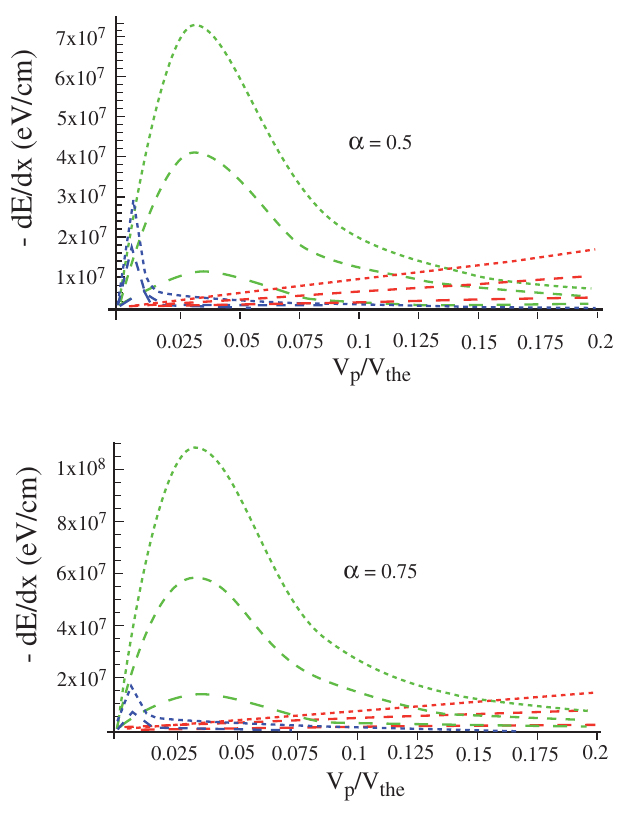
V p /V the FIG. 5. (Color) Proton stopping in H þ - U þ 238 BIM in terms of =V n ¼ 10 23 e cm (cid:1) 3 . Alpha denotes proton concentration V p the . e in BIM. T ð eV Þ ¼ ( ) 500, ( ) 1000, and ( ) 5000. Dark gray (red) pertains to e stopping, light gray (green) to H þ stopping, and black (blue) to H þ stopping. U þ 238